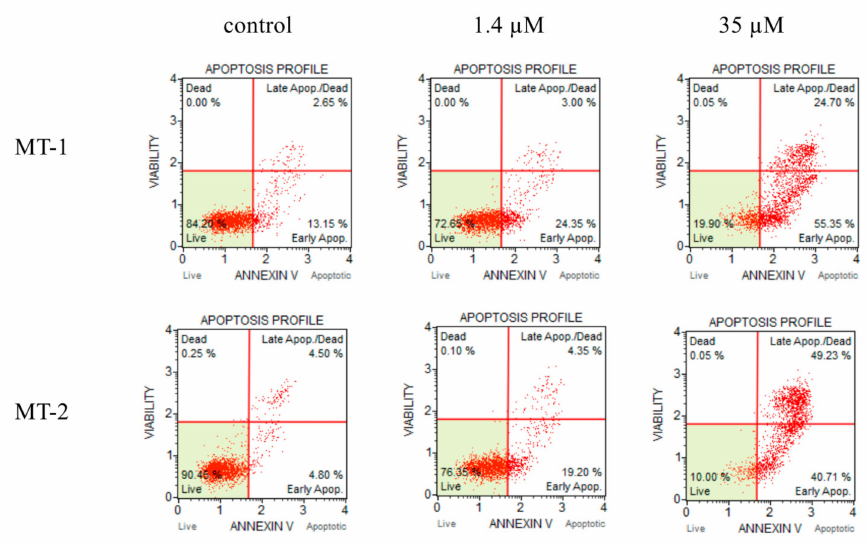
Figure 5. Isoginkgetin ( 26 ) induced cell apoptosis in MT-1 and MT-2